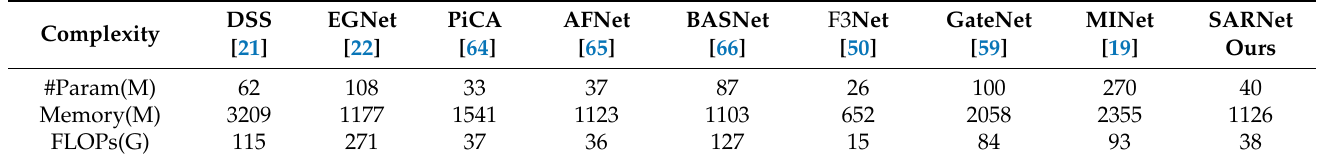
Table 5. Model complexity comparison of some CNN-based methods